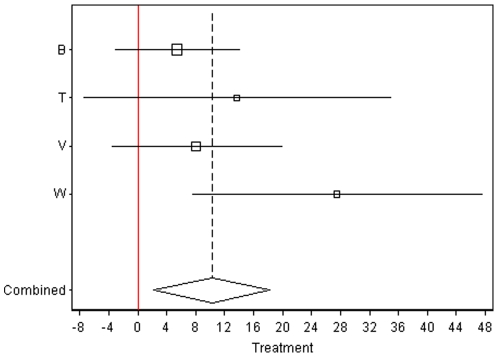
Same as Figure 3, but for the on-trail treatment group.